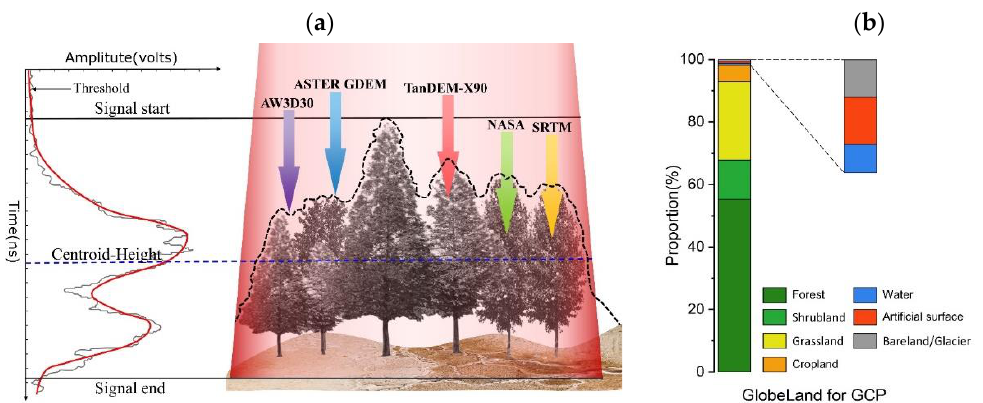
Figure 17. ( a ) The left curve in the figure is the ICESat/GLAS echo waveform curve from the vegetation-covered flat ground, and the blue dotted line represents the actual position of the ICESat elevation point. The right side of the figure shows that the penetration of the DEM into the forest canopy is different due to the different wavelengths used by the sensors generating DEM products. The approximate depth of penetration is shown by the arrow. ( b ) The proportion of GCP points in different landcover types in the study area.